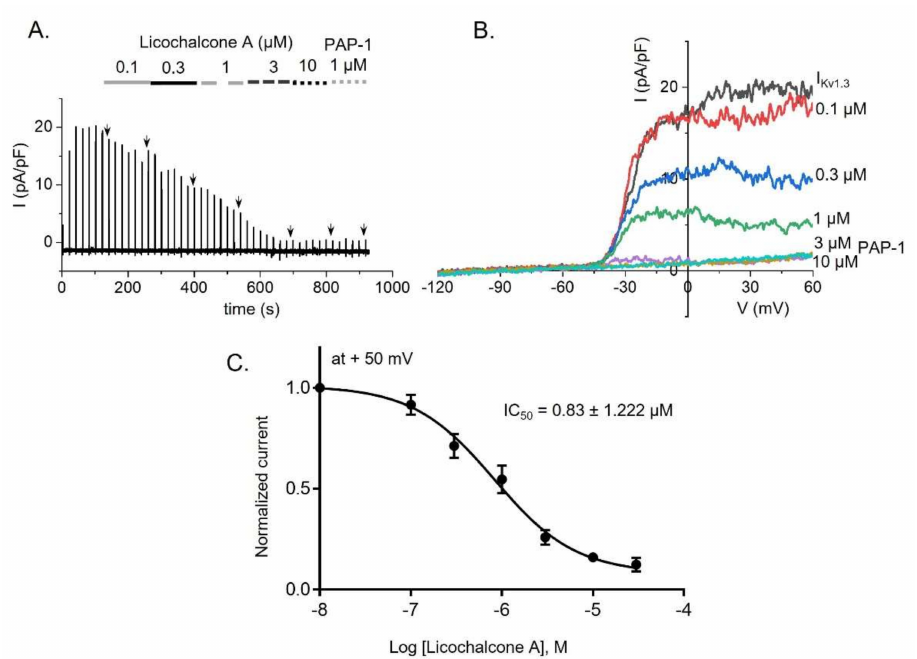
Figure 2. Inhibitory effect on Kv1.3 currents (I Kv1.3 ) by licochalcone A in Jurkat T-cells. ( A ) Whole-cell current recordings of I Kv1.3 after treatment with various concentrations of licochalcone A and PAP-1, a potent blocker of Kv1.3 channels. ( B ) Representative I-V relationships of I Kv1.3 in the cells after exposure to licochalcone A. ( C ) IC 50 value obtained from a dose-dependent curve at +50 mV is indicated. Data are presented as means ± SEM ( n = 5–11 per